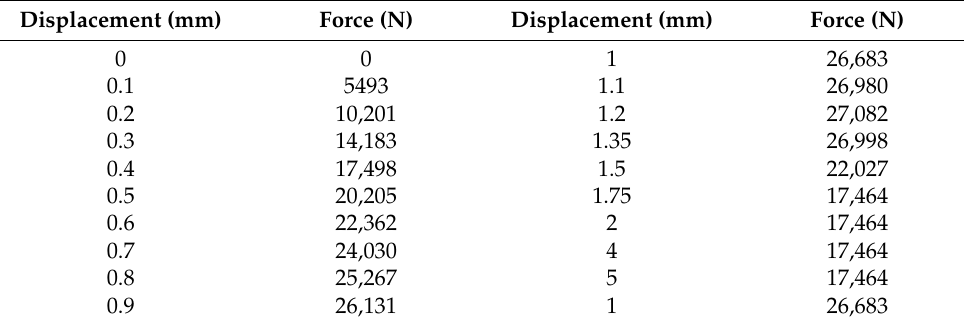
Table 9. Force–slip data for